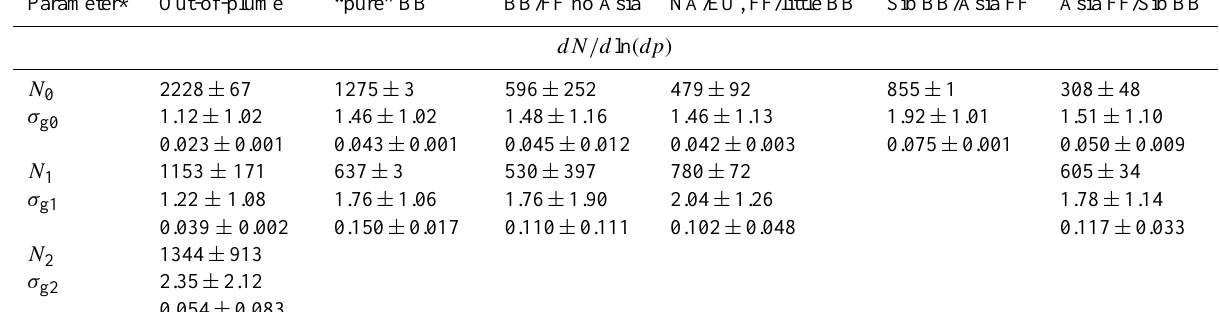
Table 6. Fit parameters for the log normal number and volume size distributions as shown in Fig. 13. Parameter* Out-of-plume “pure” BB BB/FF no